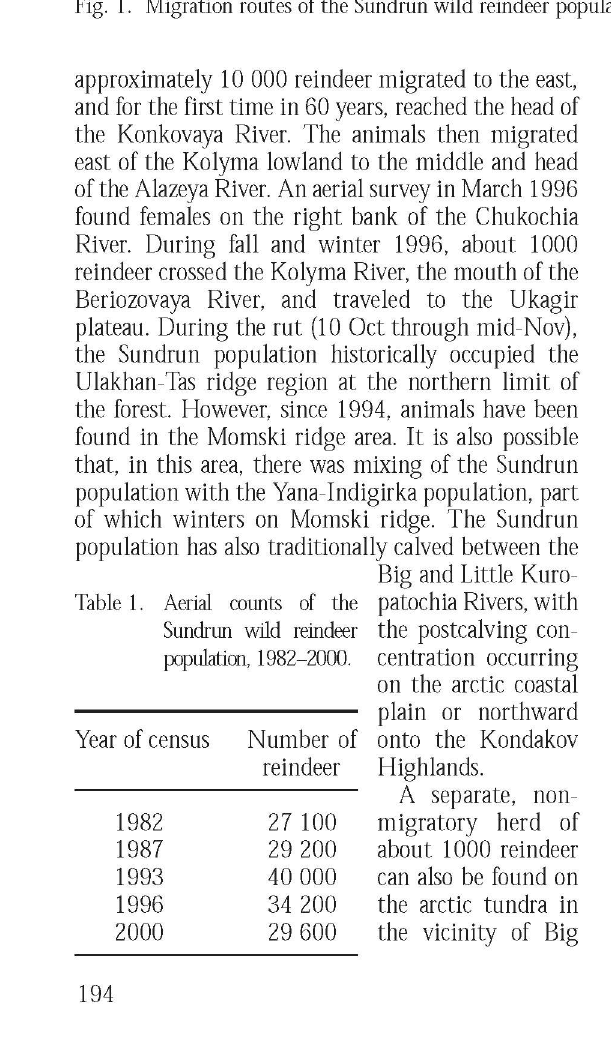
Fig. 1. Migration routes of the Sundrun wild reindeer population.